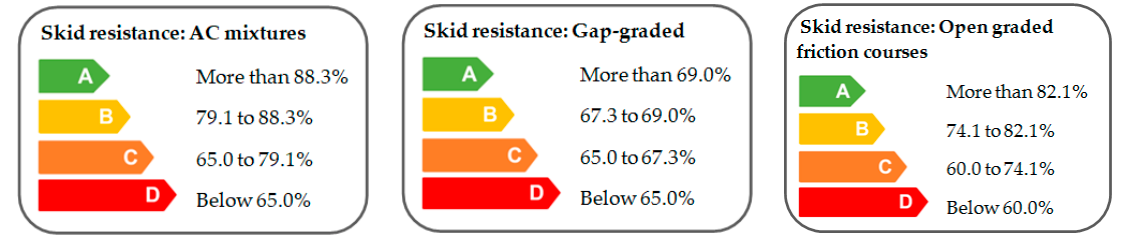
Figure 20. Skid resistance labels based on the type of mixture.